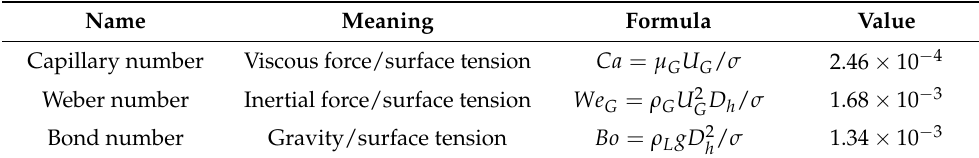
Table 2. Dimensionless